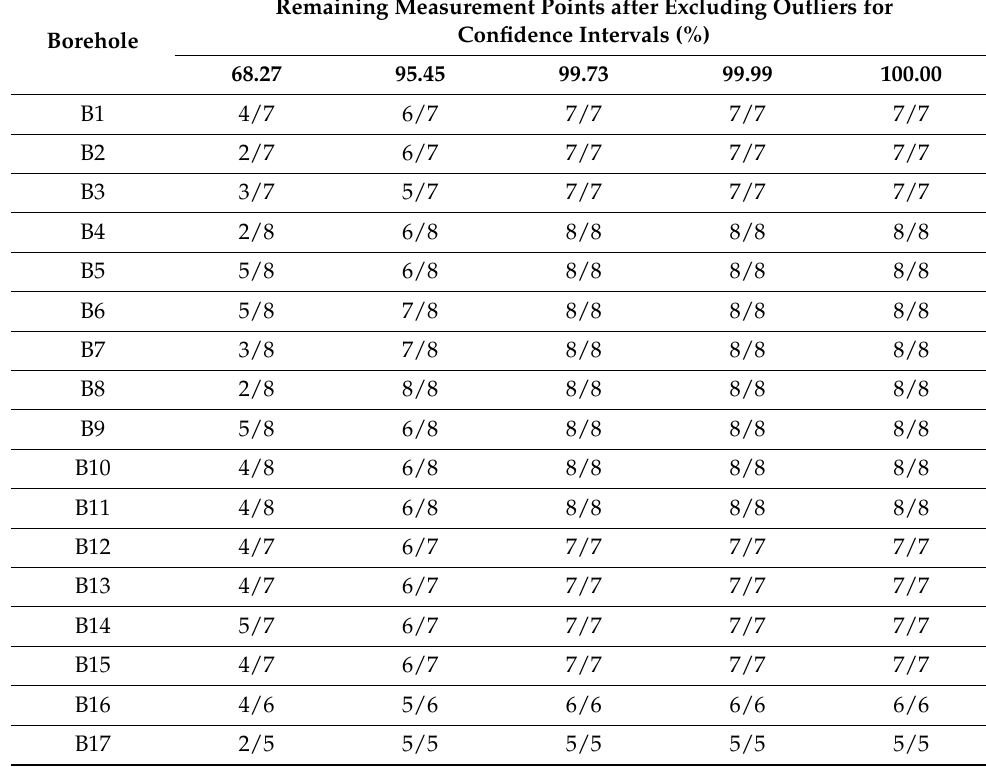
Table 5. The number of measurement points for all boreholes after the exclusion of the atypical values. Remaining Measurement Points after Excluding Outliers Borehole